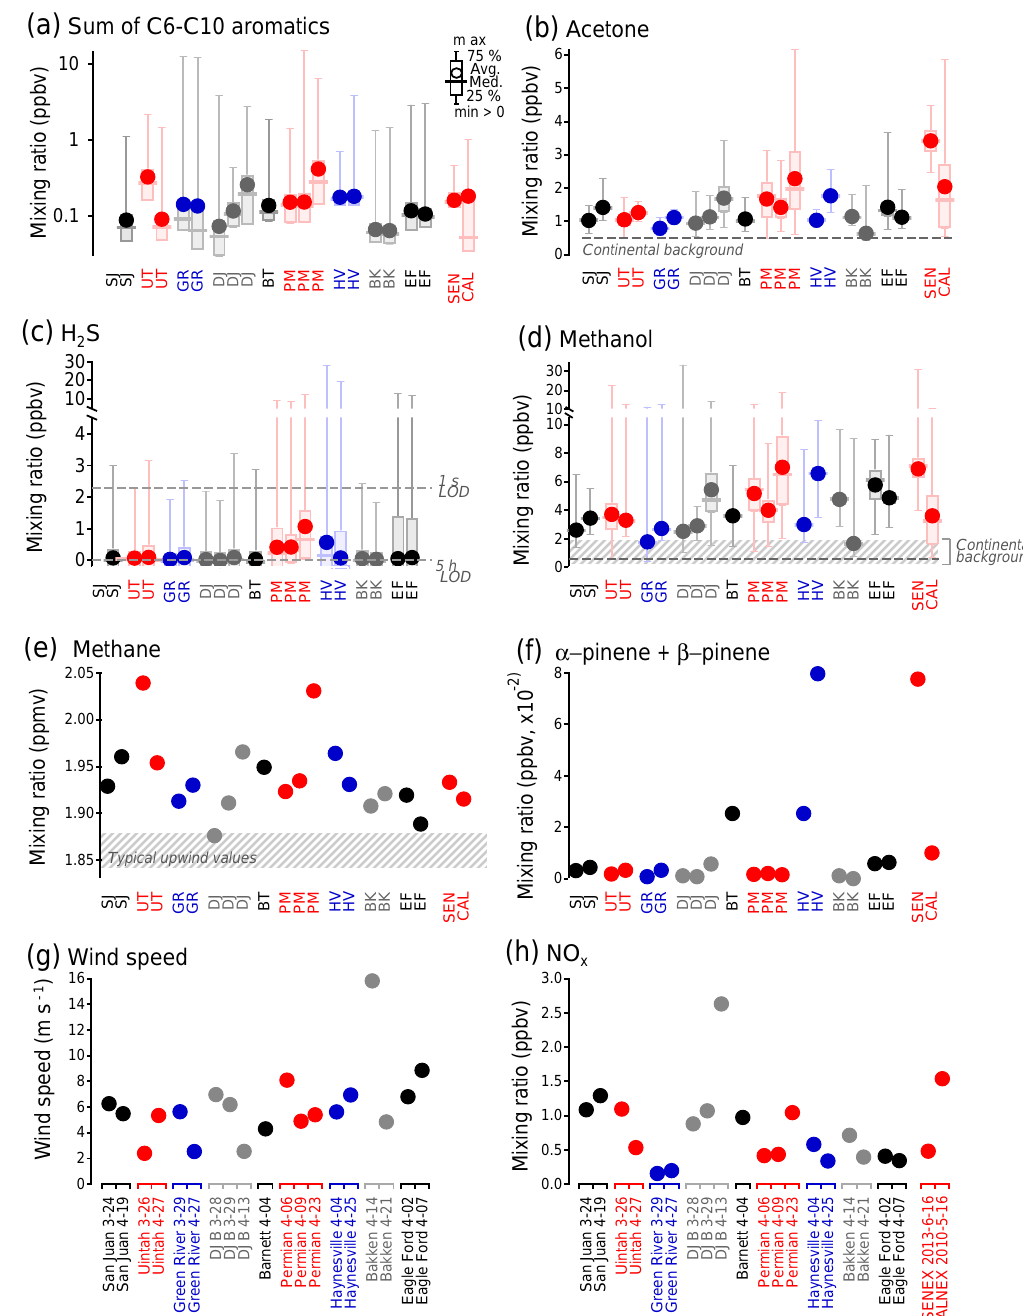
Figure 3. Mixing ratios observed within the boundary layer during SONGNEX flights. The whiskers on the PTR-ToF-MS measurement box plots (a–d) show the maximum and minimum (if above detection limit) concentrations measured across all SONGNEX flights. (a)